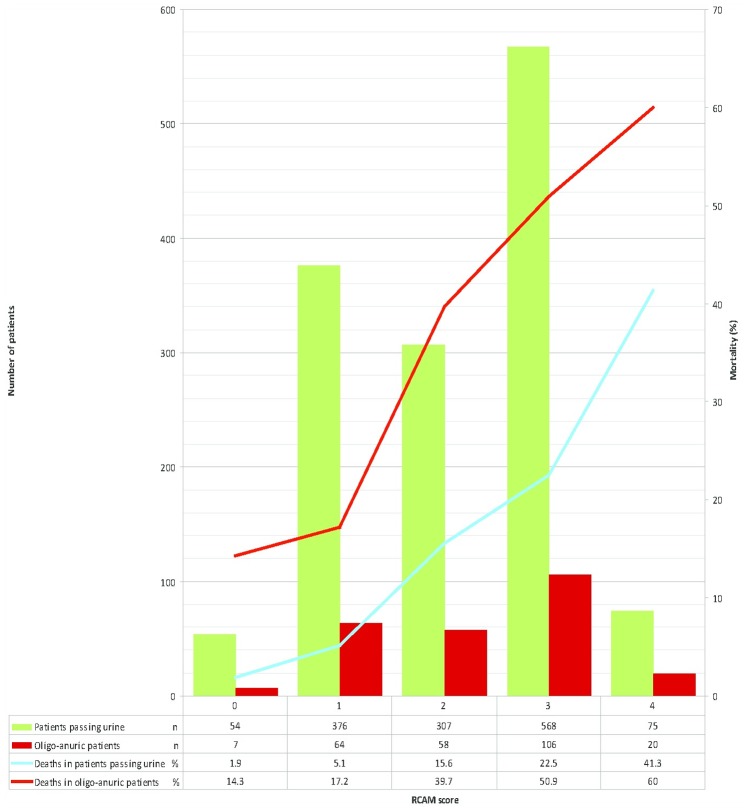
Relationship between oligo-anuria and in-hospital mortality, stratified by disease severity (RCAM score).RCAM: as defined and calculated in table 1. Oligo-anuric: urine output <10 ml first hour after catheterization.